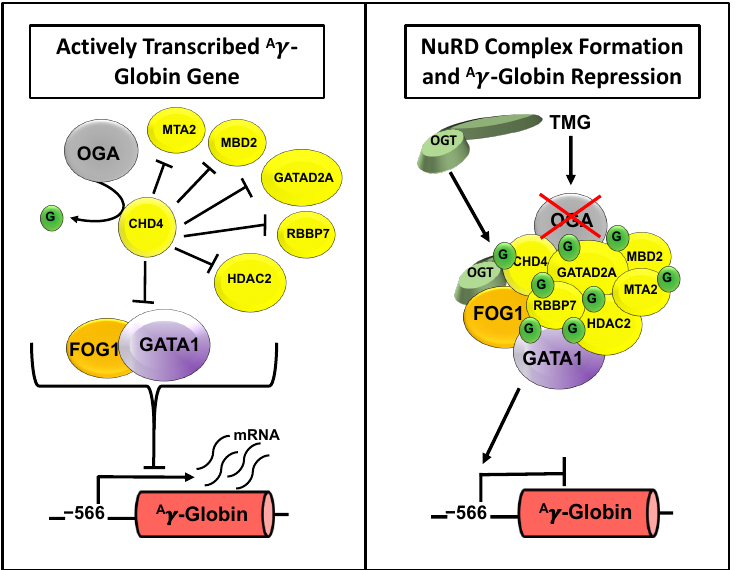
Figure 4. O-GlcNAcylation regulates the formation and function of the NuRD complex. A γ -globin expression is silenced by the recruitment of NuRD complex to the –566 GATA binding site. OGA removes O-GlcNAc (green circle “G”) from CHD4 (a subunit of the NuRD complex), thereby prevent- ing the assembly of the NuRD complex at the –566 site (left panel). When OGA is inhibited by TMG, OGT associates and O-GlcNAcylates CHD4, stimulating the formation of the NuRD complex at the –566 site, which represses A γ -globin gene transcription (right panel). Additional O-GlcNAc sites have been found on every subunit of the NuRD complex, however, their function remains